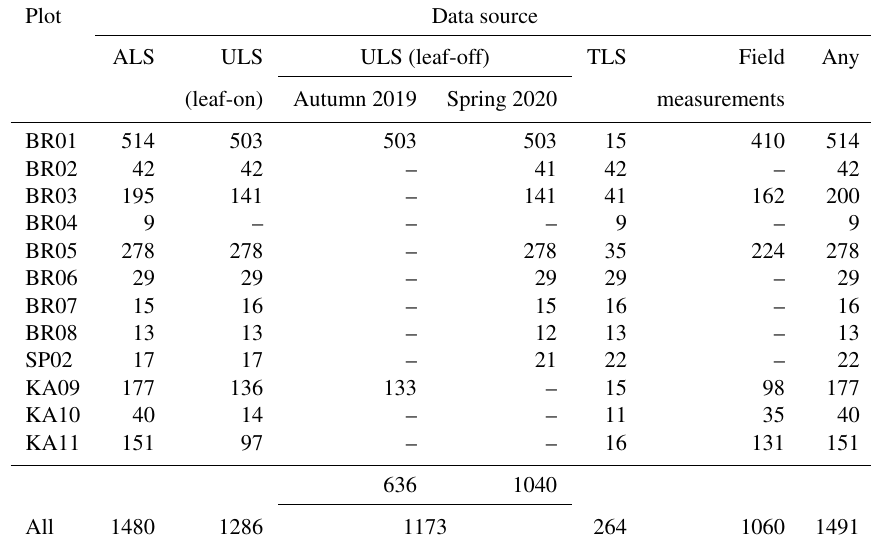
Table 5. Number of trees per plot and data source. Note that most trees were measured from different platforms and at different times. ULS leaf-off data are available for 1173 trees. Of these, 133 trees were measured in autumn 2019, 537 trees were measured in spring 2020 and 503 trees were measured both in autumn 2019 and spring 2020.